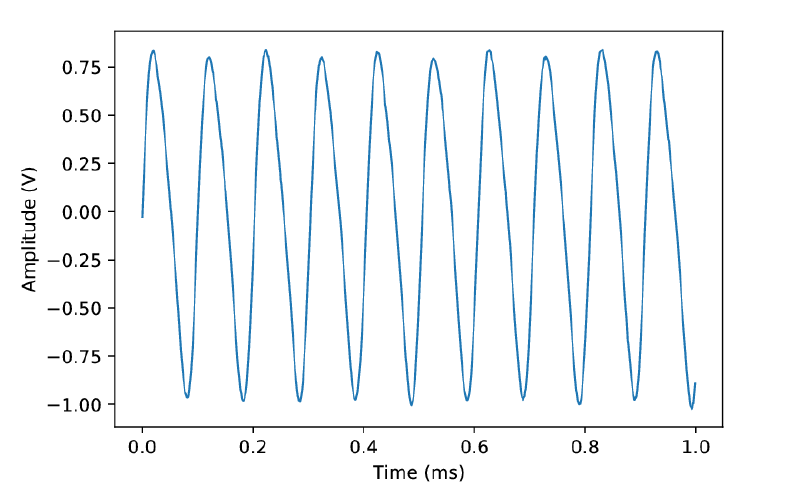
Figure 13. Sensor 2 output for the SO-3 turbojet at idle.